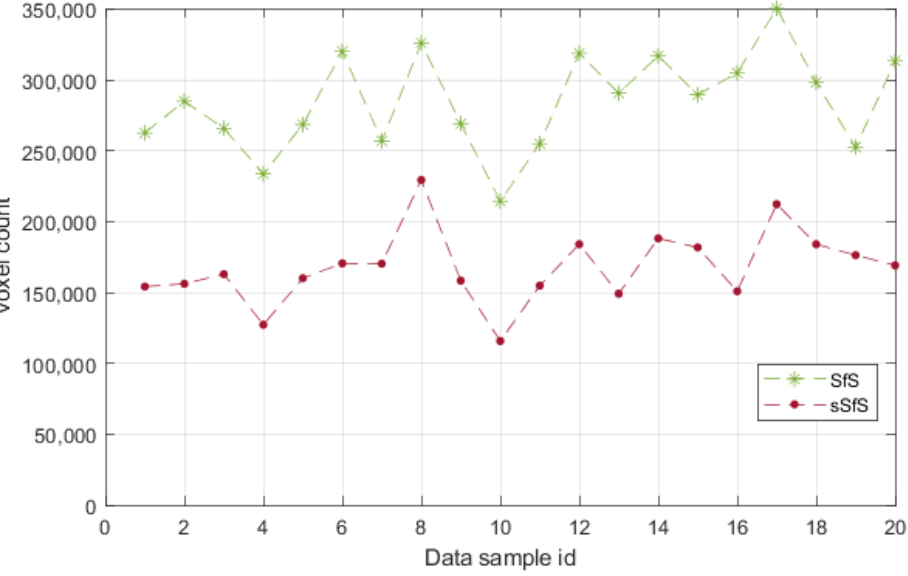
Figure 8. The erroneous voxel counts for SfS and sSfS reconstructions of the validation